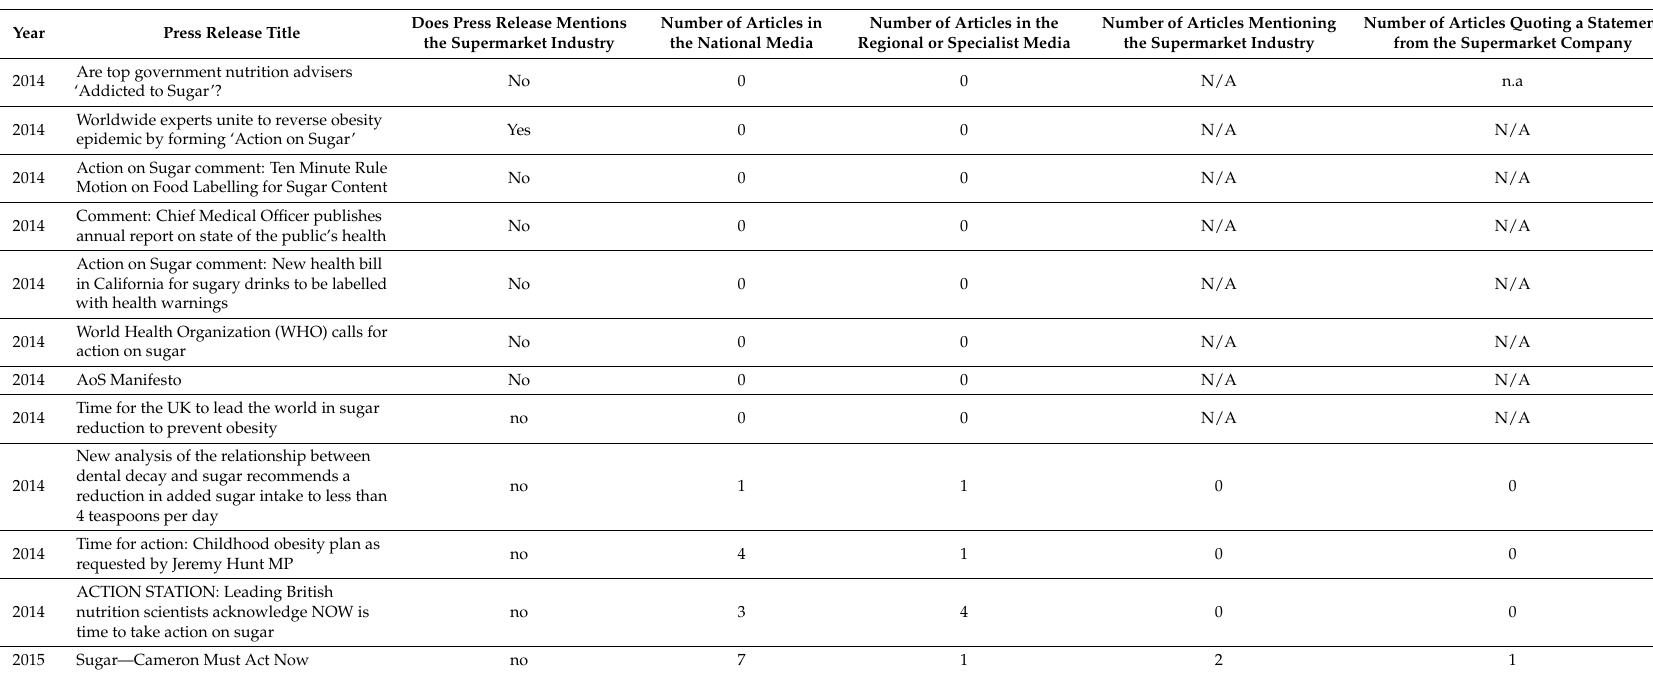
Table 4. Mentions and Statements of Supermarkets in Media Articles following Press Releases from Action on